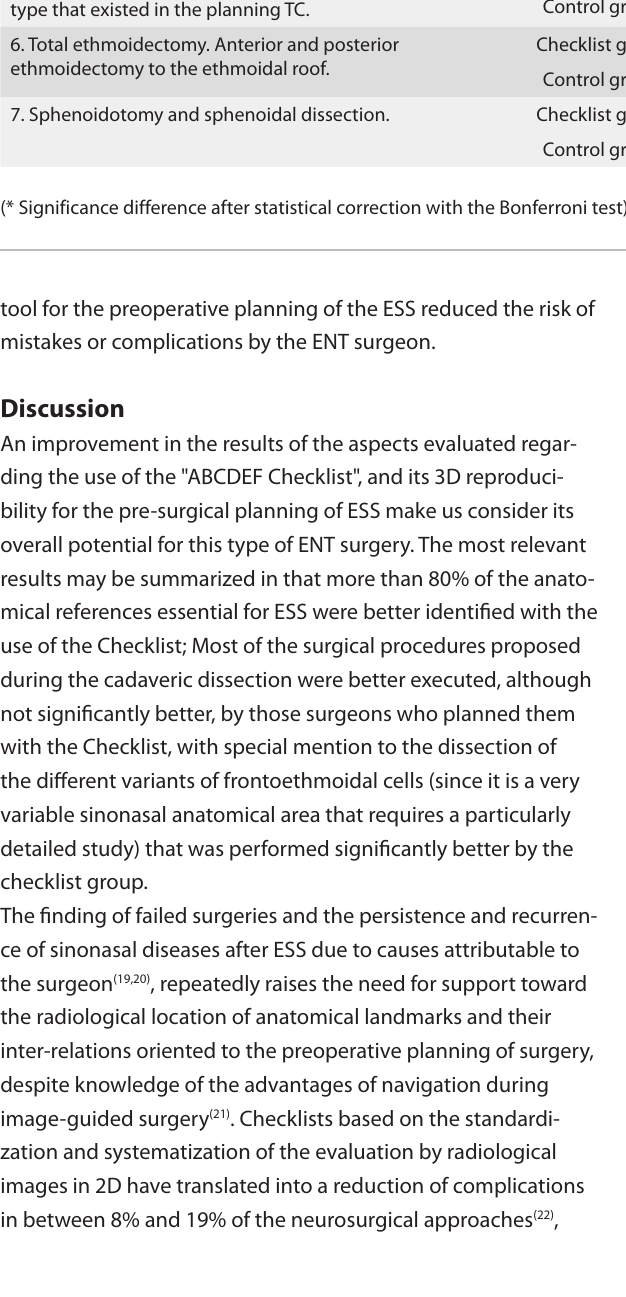
(* Significance difference after statistical correction with the Bonferroni